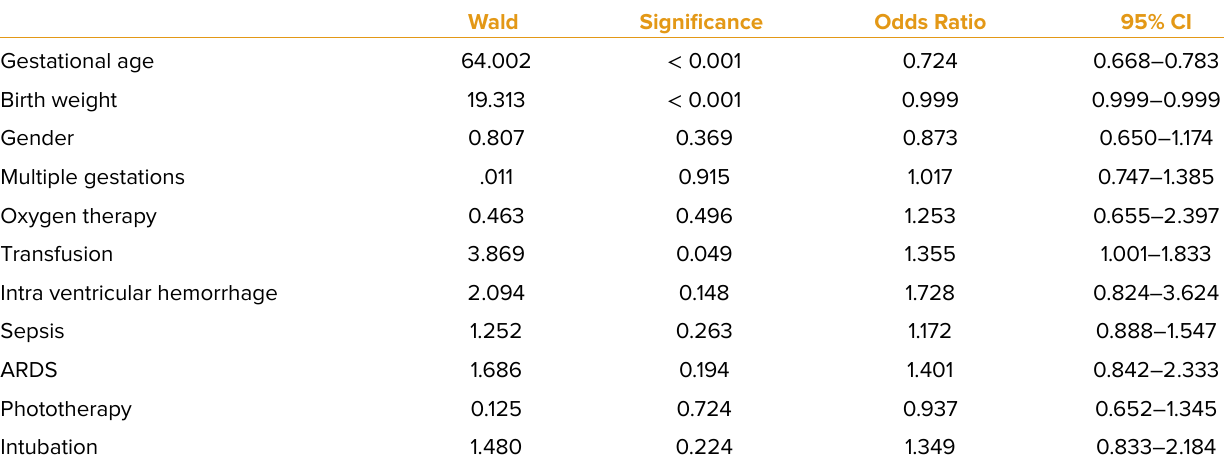
Table 3. Data of multivariate regression analysis of different risk factors in the development of retinopathy of prematurity